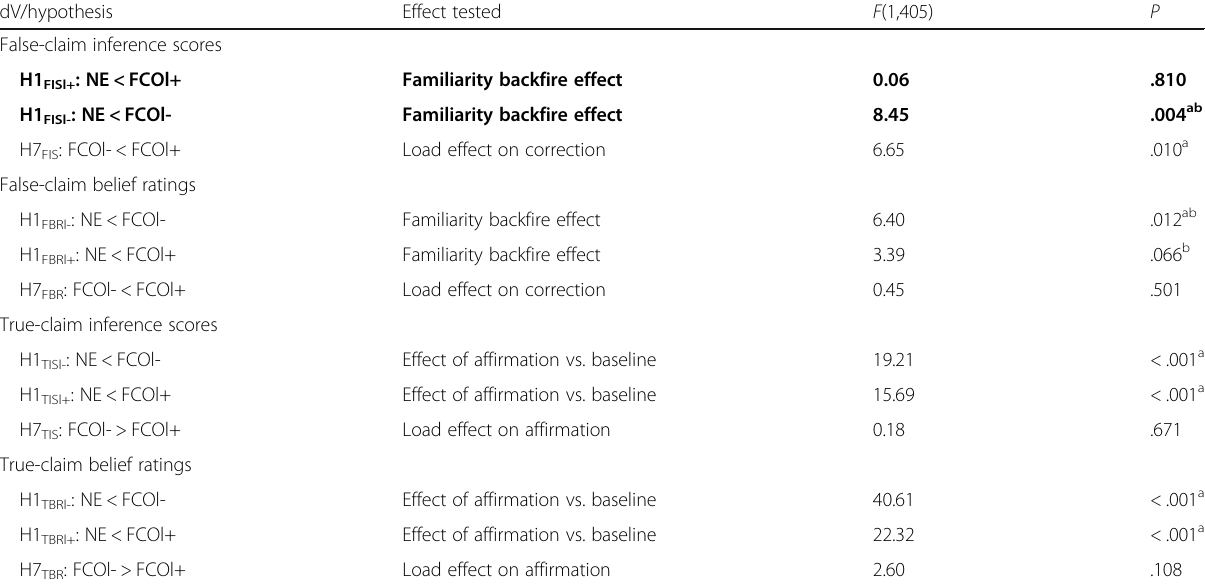
Table 3 Contrasts run in Experiment